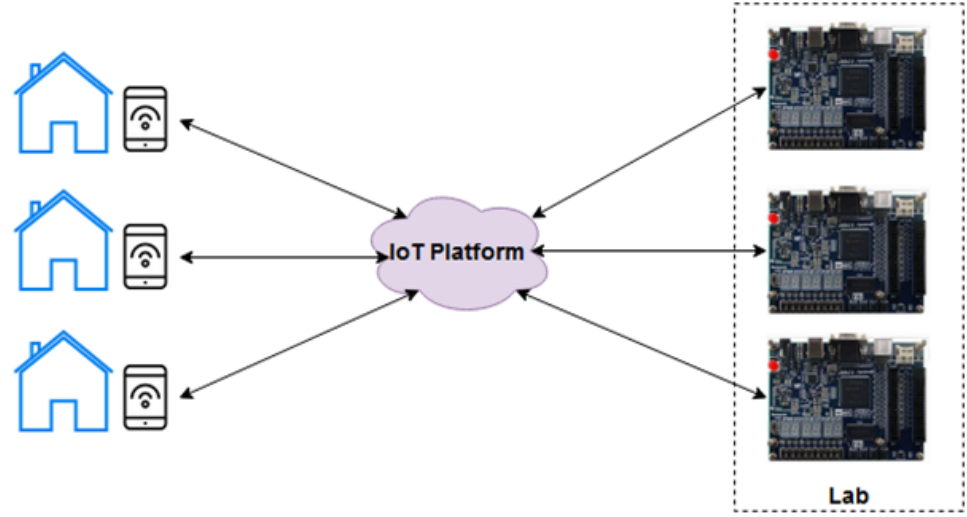
Figure 2. LabEAD high-level concept. Students perform activities from home by interacting with mobile devices and the FPGA boards are accessed using an IoT platform (as illustrated by the communication